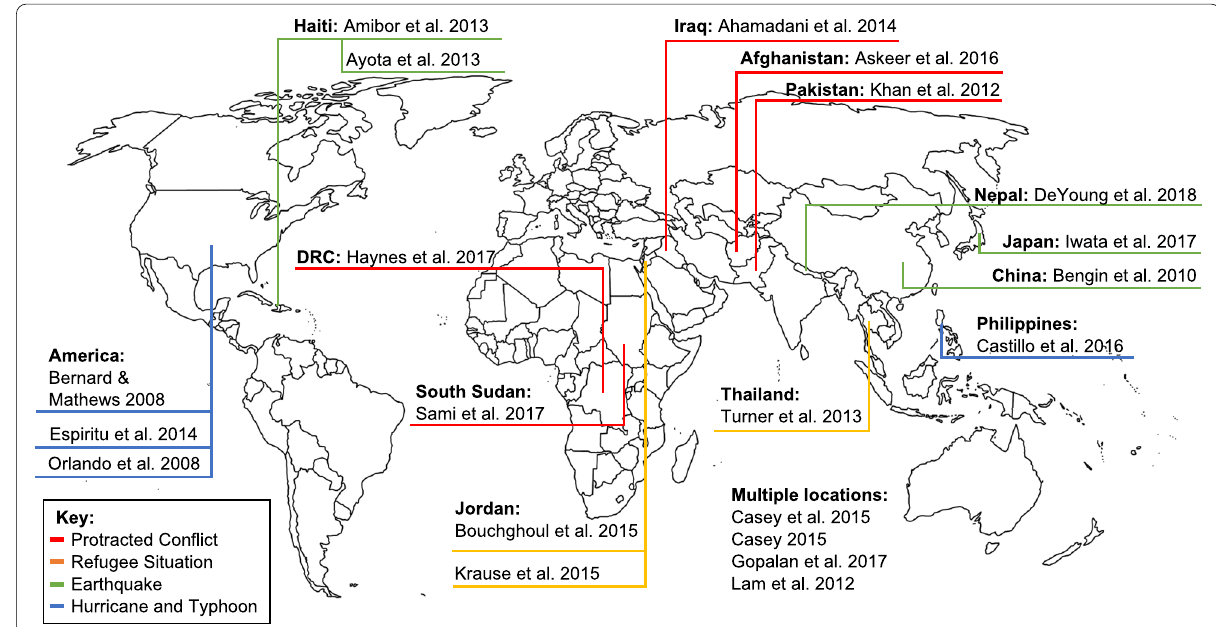
Fig. 2 Geographical distribution of included